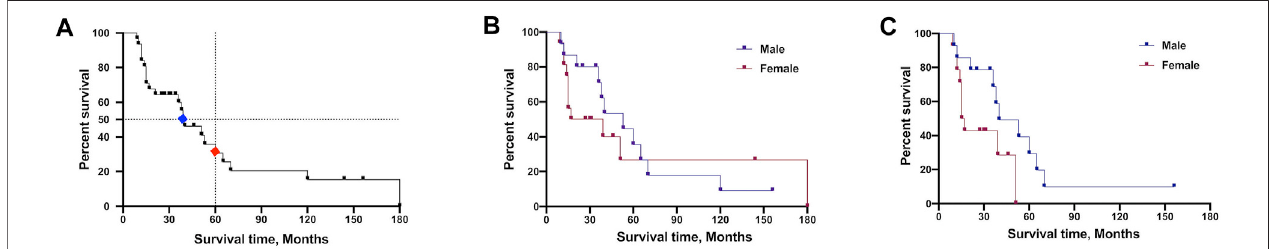
FIGURE 4 | Survival analysis comparison of patients carrying SOD1 mutations. (A) Plot of survival probabilities for all patients with SOD1 mutations. The overall median survival time is seen in blue mark (40 months), and the 5-years survival rate is seen in red (30.7%). (B) Plot of survival probabilities between all male and female patients (median survival 53 vs. 28 months, p (cid:1) 0.63). (C) Plot of survival probabilities between male and female patients after excluding the H47R mutation data, indicating that males had a longer survival time than females (median survival 40 vs. 16 months, p (cid:1)